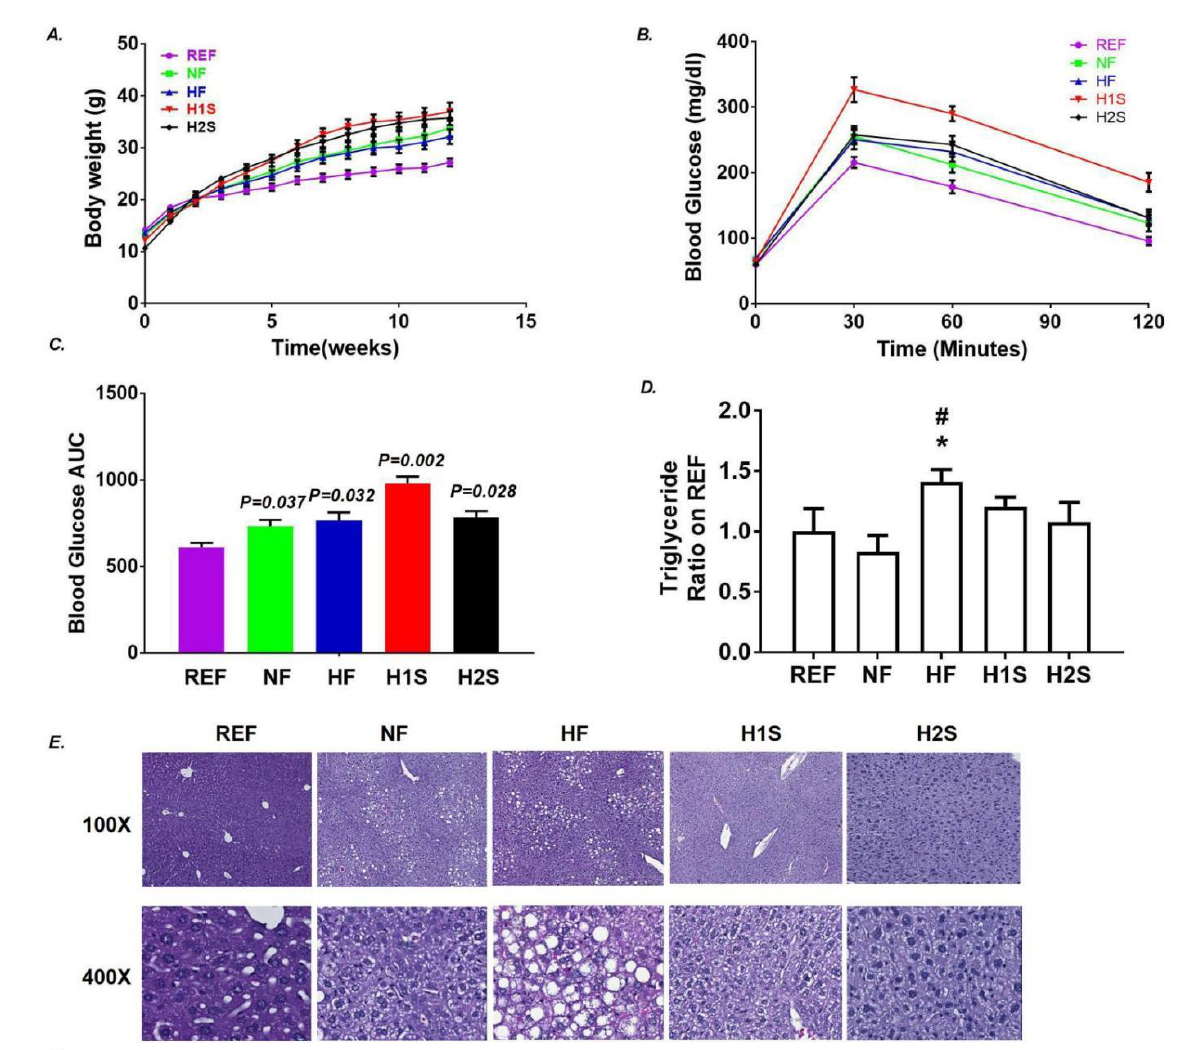
Figure 1. Maternal one-carbon supplementation allowed offspring to avoid NAFLD promoted by a maternal HF diet but not obesity and glucose intolerance. ( A ) Body weights of male offspring were recorded weekly after weaning for 12 weeks. ( B ) IPGTT was measured at the end of week 12 in male offspring. ( C ) The areas under the curve (AUCs) were calculated for the IPGTT results in male offspring. ( D ) Serum triglyceride was detected in male offspring. ( E ) H&E staining was performed on the liver tissue of male offspring. Data are presented as the mean ± SE, n = 15. * indicates p < 0.05 vs. the NF group. # indicates p < 0.05 vs. the REF group.